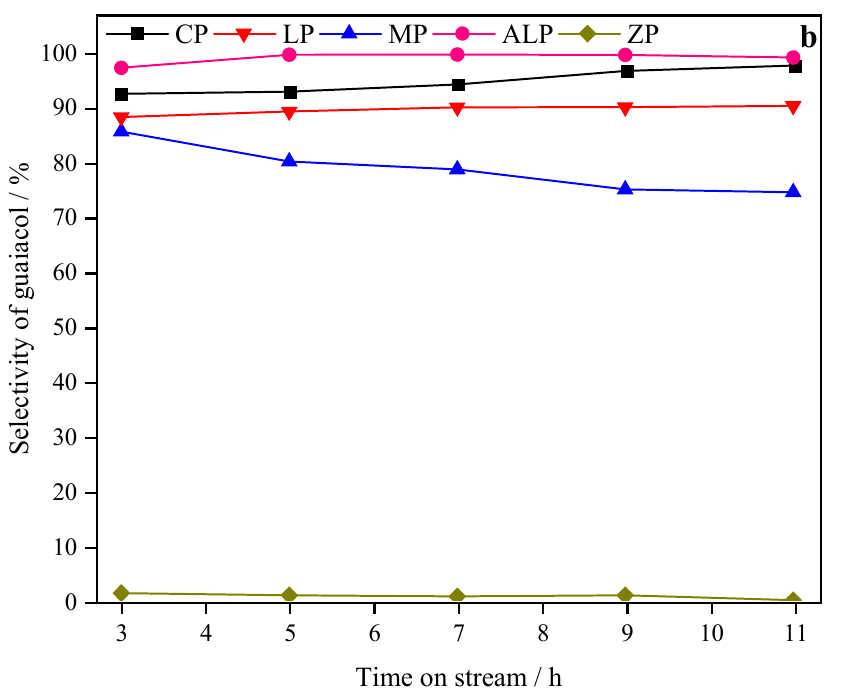
Figure 4. Effect of time on stream on catechol conversion ( a ) and guaiacol selectivity ( b ) over different metal phosphate catalysts. Reaction conditions: atmospheric pressure; T = 270 °C; WHSV = 0.4 h − 1 .